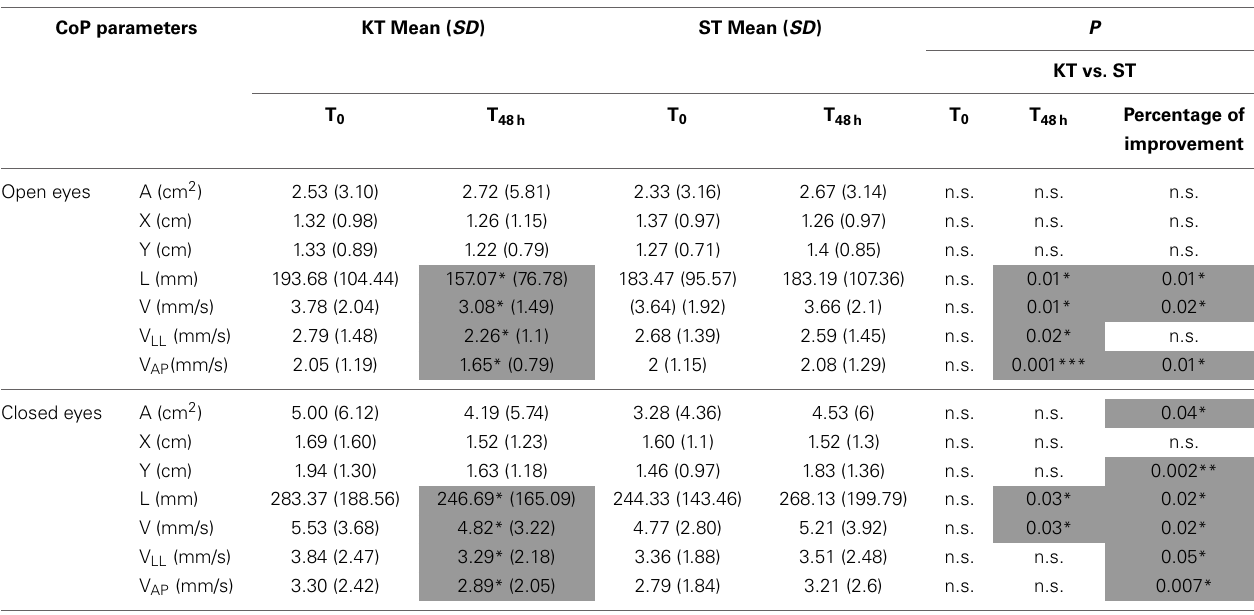
Table 3 | Balance